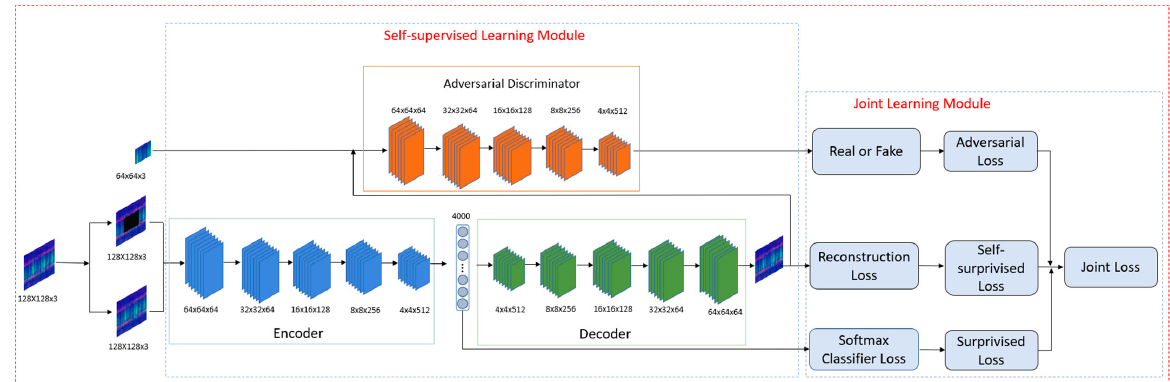
Figure 3. The architecture of the SSJL.